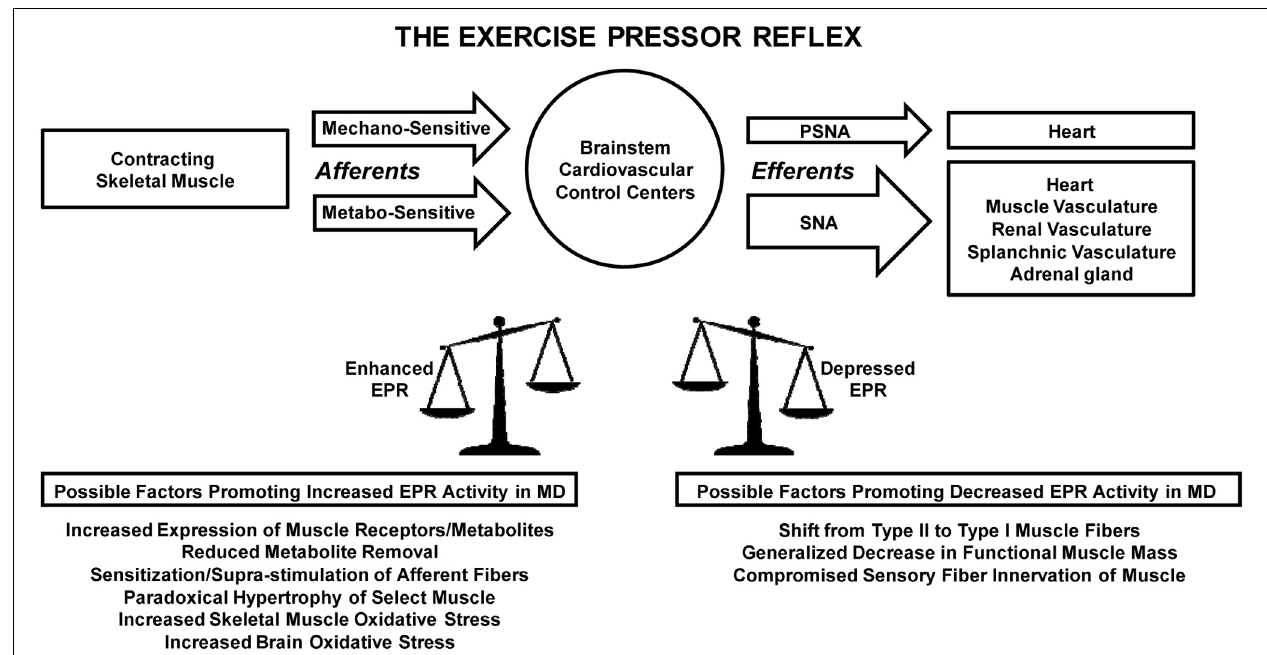
FIGURE 1 | Theoretical model of factors that could influence exercise pressor reflex function in muscular dystrophy. During muscle contraction, the exercise pressor reflex is engaged upon stimulation of receptors which activate mechanically and metabolically sensitive afferent fibers innervating skeletal muscle. Sensory signals from these fibers are processed within autonomic control centers in the brainstem evoking decreases in parasympathetic nerve activity to the heart and